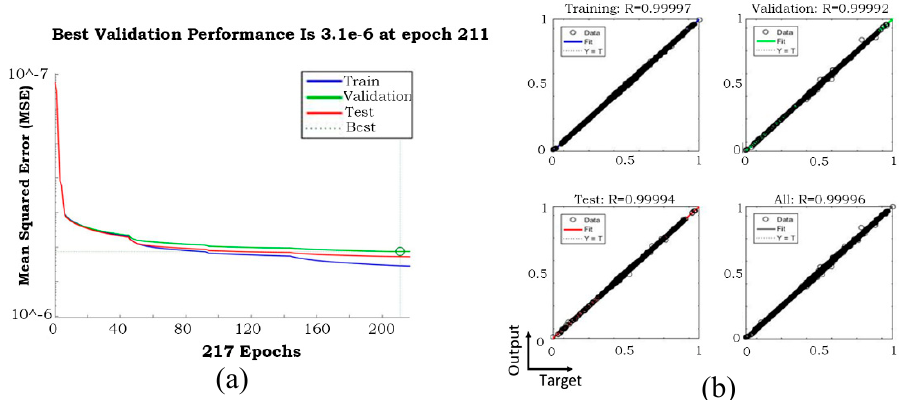
Figure 11. NN ( a ) validation performance and ( b ) regression when temporal time-step was 0.001 s.